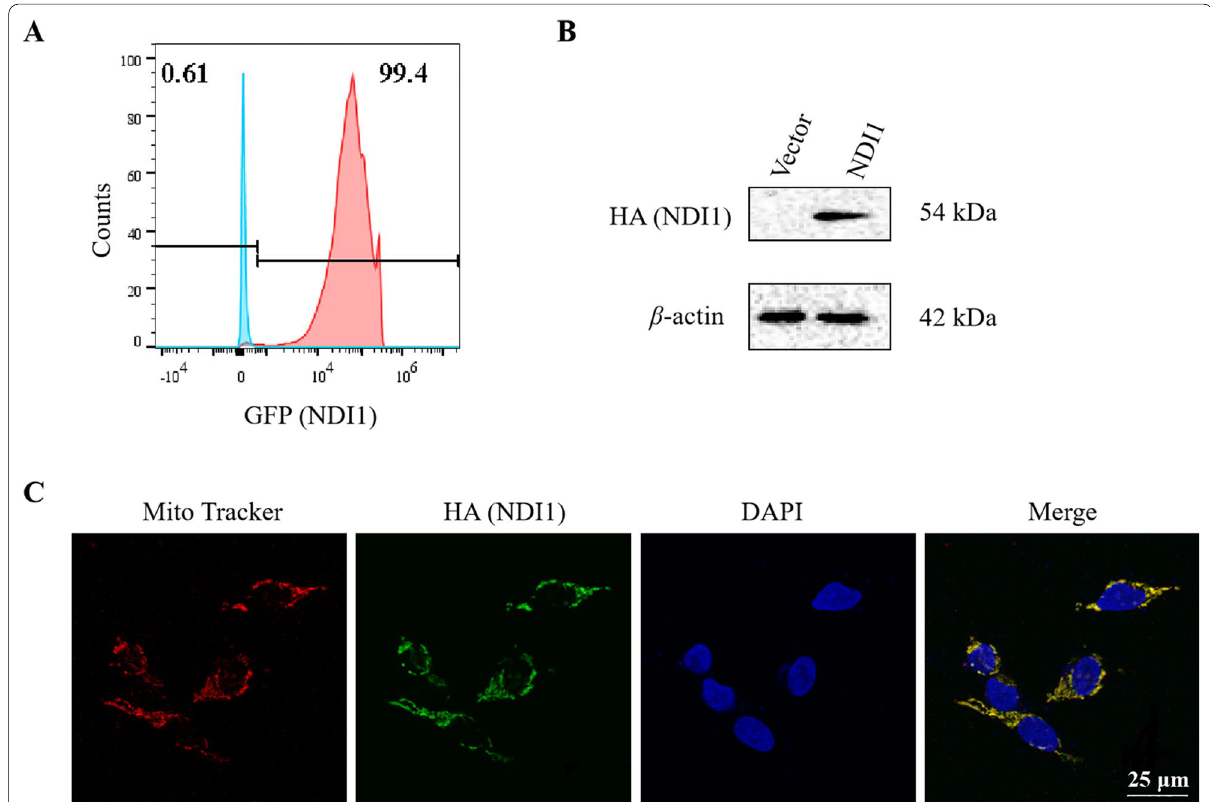
Fig. 1 NDI1 expression and subcellular localization after transduced to SH-SY5Y cells. A GFP (NDI1) positive cells were analyzed by flow cytometry. B The expression of HA (NDI1) was examined by western blot using HA antibody with β-actin as loading control. C Mitochondrial localization of HA (NDI1) was verified by a confocal microscope. The LV-NDI1 transduced SH-SY5Y cells were co-stained with MitoTracker dye (red) and HA antibody (green), and counterstained with DAPI (blue). Scale bar 25 =